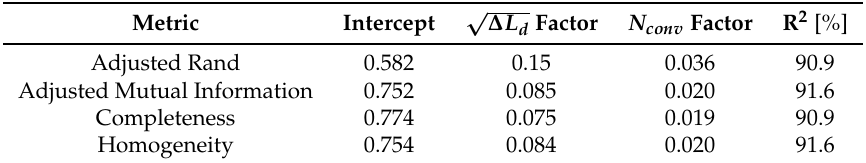
Table 3. Results of Linear model fitting of Equation (7).